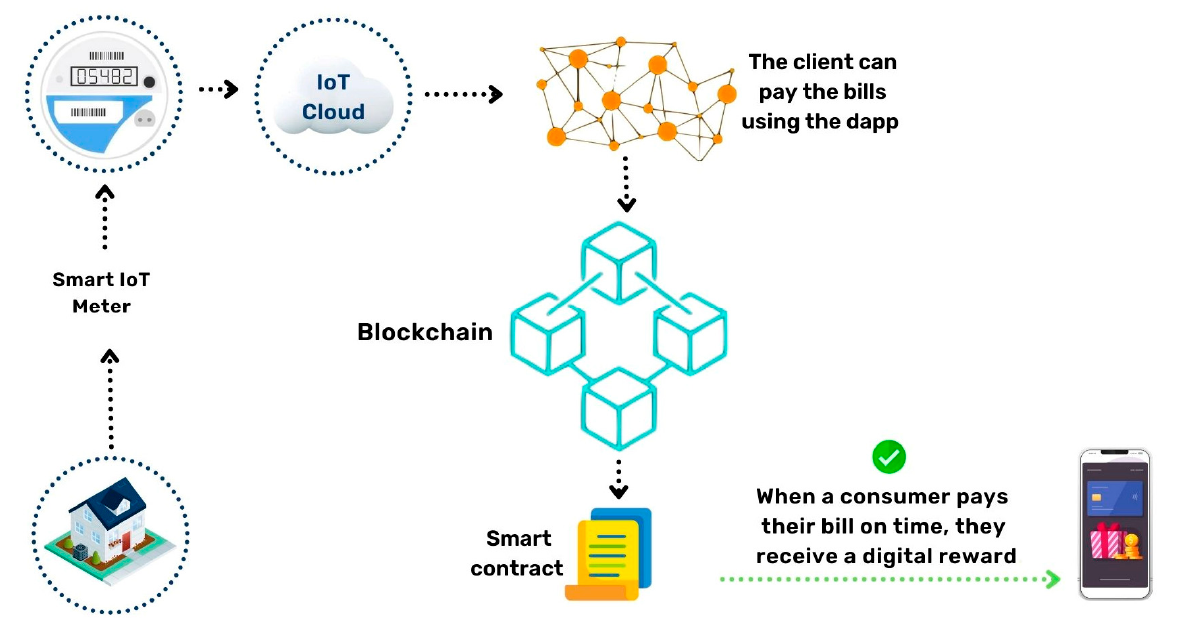
Figure 1. Proposed Blockchain-Based Consumer Electronic Data Sharing and Secure Payment.